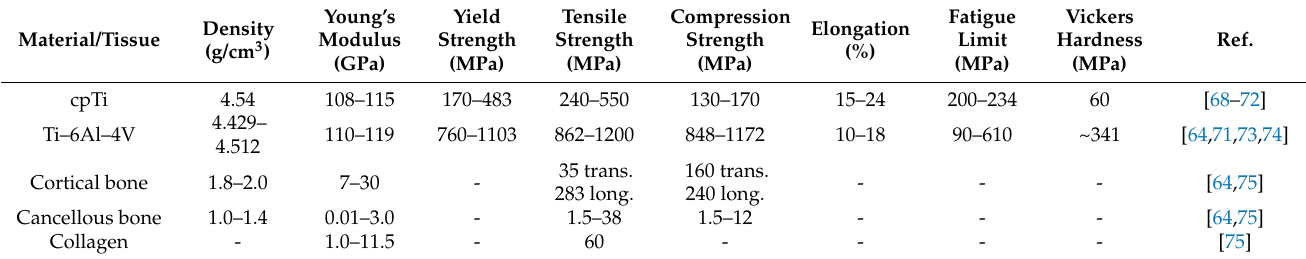
Table 2. Mechanical properties of Ti implant material and human